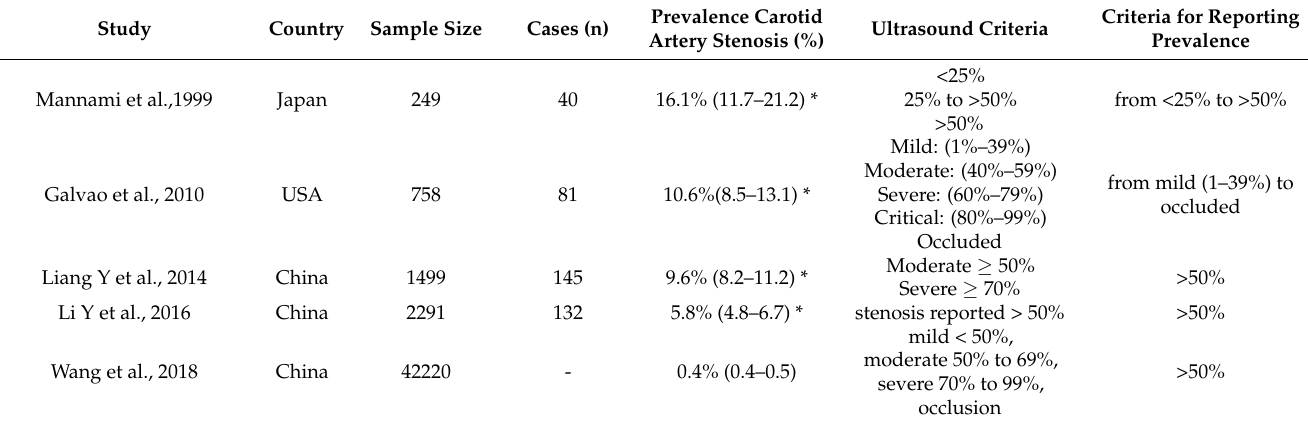
Table 3. Prevalence of carotid artery stenosis from retrieved